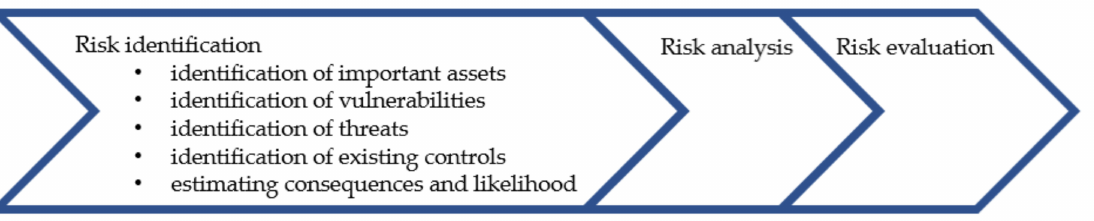
Figure 1. ISO/IEC 27005:2108 risk assessment